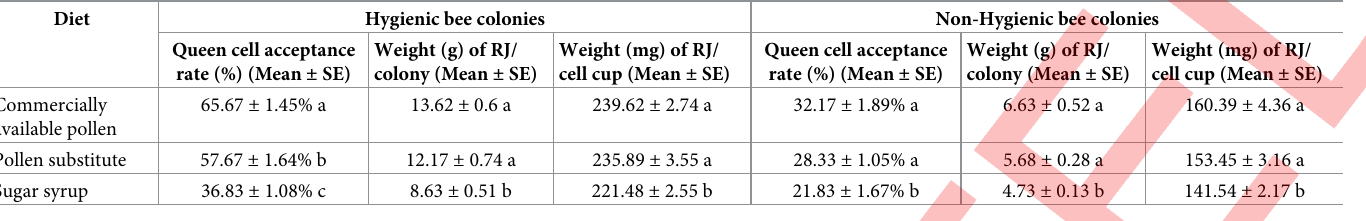
Table 1. The effect of nutritional diets on the queen cell acceptance rate, royal jelly/ colony/cell cup between hygienic and non-hygienic bee colonies. Diet